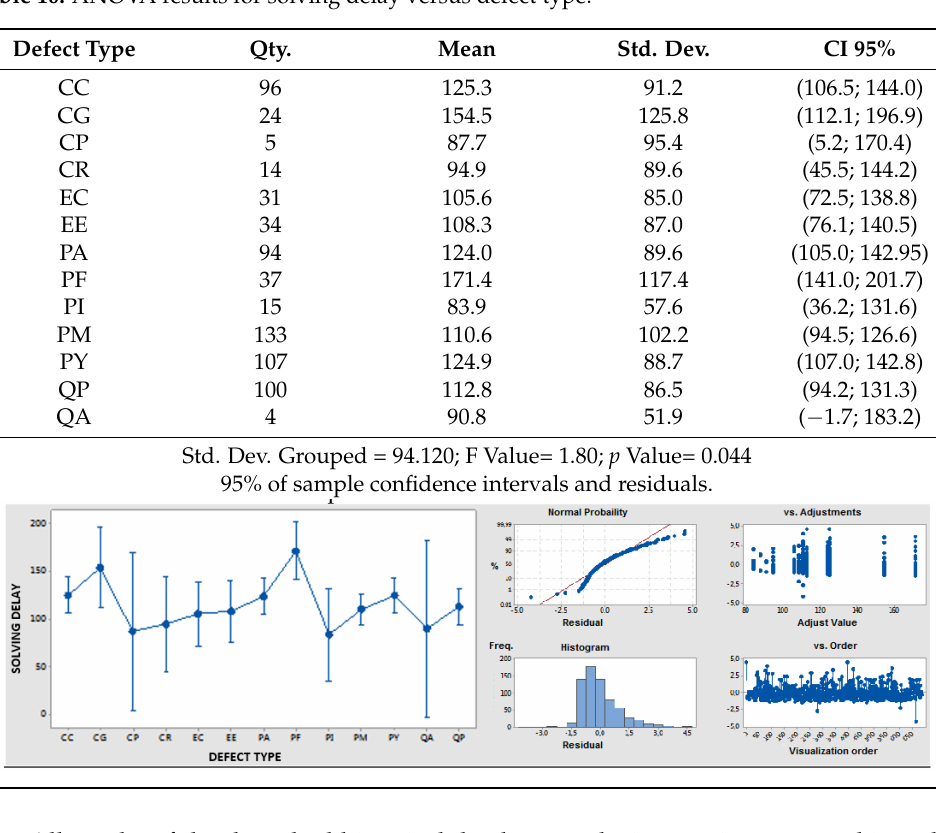
Table 10. ANOVA results for solving delay versus defect type.